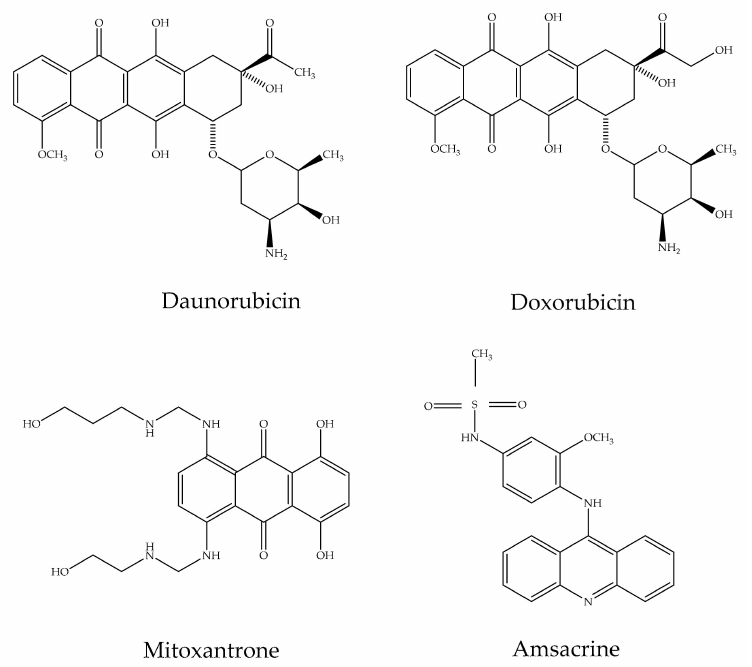
Figure 3. DNA-intercalating anthraquinones of clinical